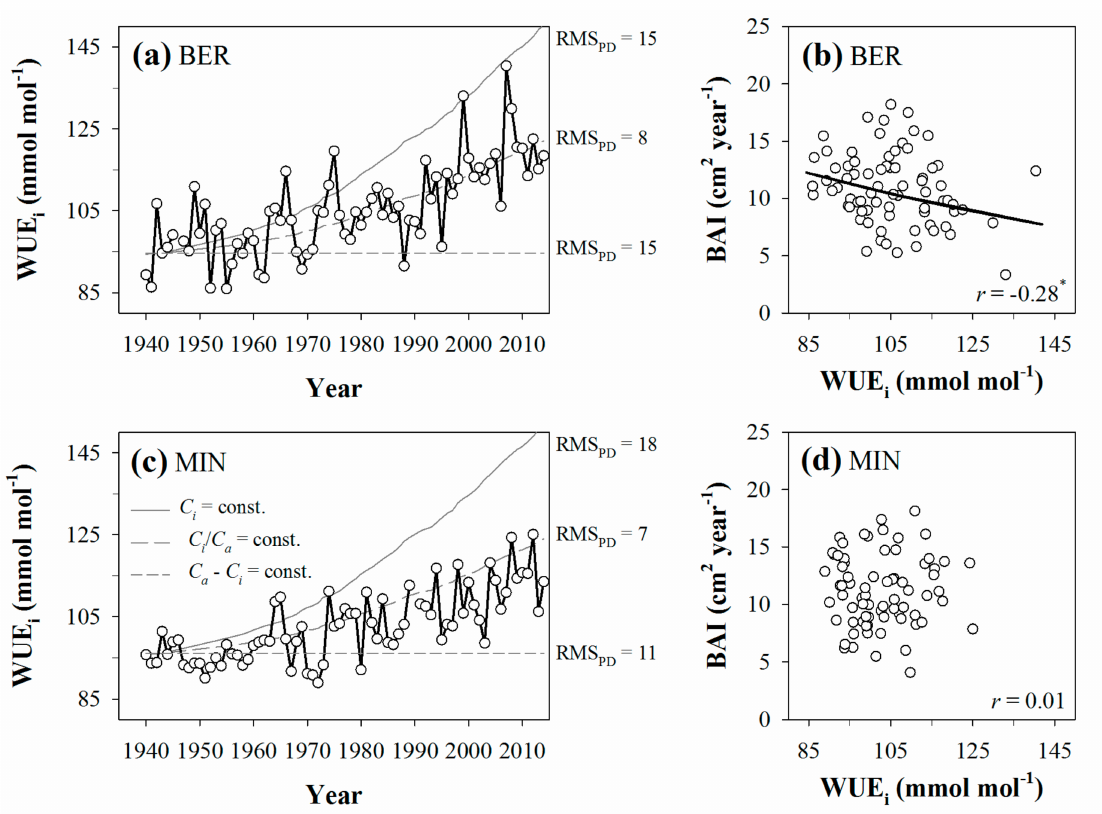
Figure 5. Long-term evolution of intrinsic water use efficiency (WUE i ) and its relationship with basal area increment (BAI) for BER (upper panels) and MIN (lower panels) for the period 1940–2014. ( a , c ) Temporal trends in intrinsic water use efficiency (WUE i ) as related to three conceptual models assuming a constant intercellular CO 2 concentration ( C i = const. scenario; solid line), a constant ratio between intercellular and atmospheric CO 2 concentrations ( C i / C a = const. scenario; long dashed line) and a constant difference between atmospheric and intercellular CO 2 concentrations ( C a − C i = const. scenario; short dashed line). The root mean square predictive difference (actual minus predicted values; RMS PD ) is shown for each model. ( b , d ) Relationships between WUE i and basal area increment (BAI). A significant trend over time is depicted with a black line (*, p <